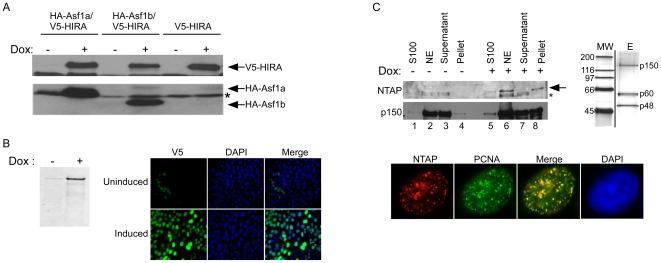
Use of the lentiviral Destination vectors to overexpress proteins.(A) Generation of three VA13 cell lines inducibly expressing either V5-HIRA, V5-HIRA and HA-Asf1a, or V5-HIRA and HA-Asf1b. (A) Cells were first transduced with the pLenti TetR Blast lentivirus and selected with blasticidin. These cells where then transduced with either the pLenti CMV/TO V5-HIRA Hygro virus alone or in combination with either the pLenti CMV/TO HA-Asf1a Puro or pLenti CMV/TO HA-Asf1b Puro virus. After appropriate drug selection, the cells were tested for the expression of the respective proteins before or after induction with Doxycycline for 48 h by anti-epitope Western blot. The * represents a cross-reacting band detected by the anti-HA antibody used as loading control. (B) Inducible expression of XPG-V5 from pLenti CMV/TO Zeo in U2OS cells monitored by Western blot (left) and immunofluorescence (right). In the whole population, very few cells (<1%) showed leakiness in the uninduced control; we photographed a field with some leaky uninduced cells. (C) LEFT: Western blot of Streptavidin pulldowns from HeLa S3 TREx-NTAP-p150 nuclear extracts (NE) without (lanes 1–4) or with (lanes 5–8) doxycycline induction (2 µg/ml) probed with anti-CBP (NTAP blot) or anti-p150. The distribution of NTAP-p150 during the nuclear extraction is the same as the endogenous p150, mainly absent from the cytosolic (S100) extract and present in the nuclear extract. The arrow represents NTAP-p150, where as the asterisk represents cross-reactivity of the antibody since it is in the uninduced samples and is not pelleted by the streptavidin beads (lane 8). RIGHT: Silver stain profile of purified NTAP-p150 (lane E) on a 5–20% gradient SDS-PAGE gel showing the p150, p60 and p48 subunits of CAF-1 migrating at their corresponding molecular weight (MW). BOTTOM: Immunofluorescence of NTAP-p150 shows that it is localized to replication foci as shown by its colocalization with PCNA.